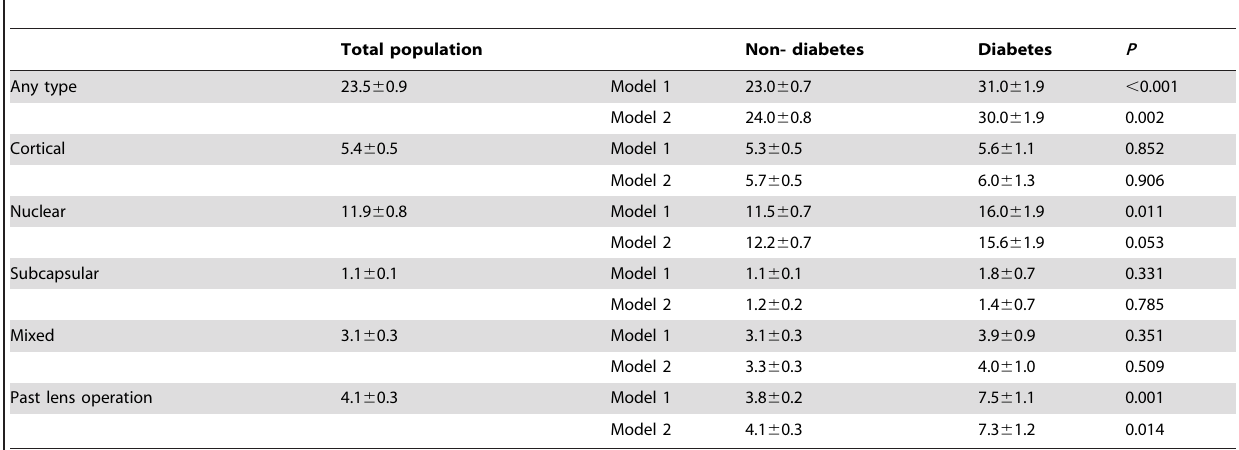
Table 3. Weighted prevalence (%) for different types of lens opacity by the presence of diabetes.